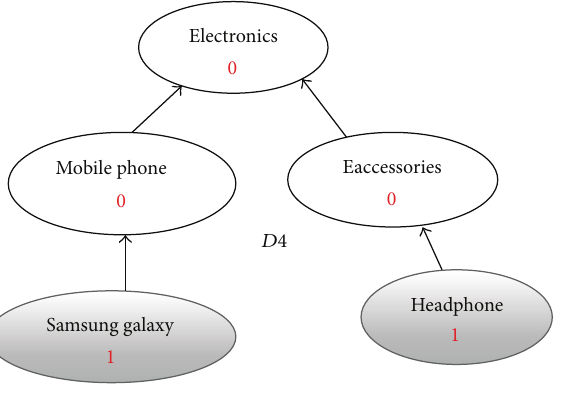
Figure 10: Shortest path for 𝐷4 .